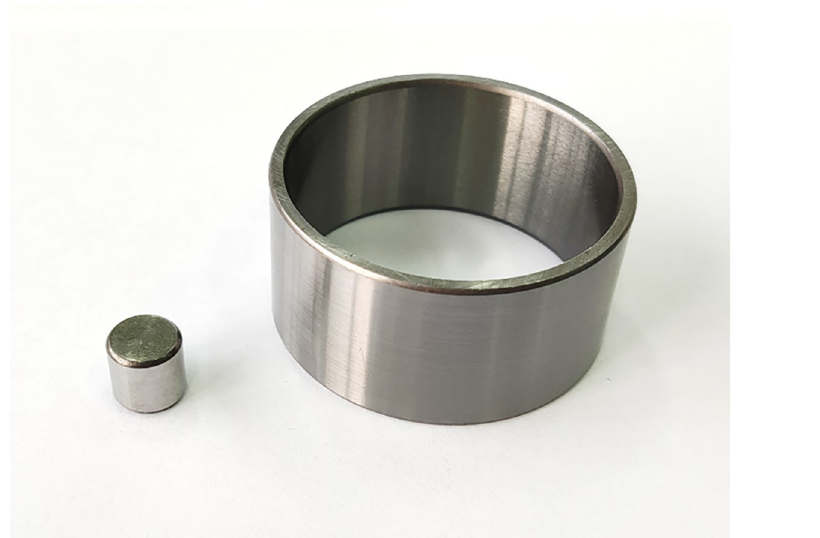
Fig 2. The ring and block of test specimens.